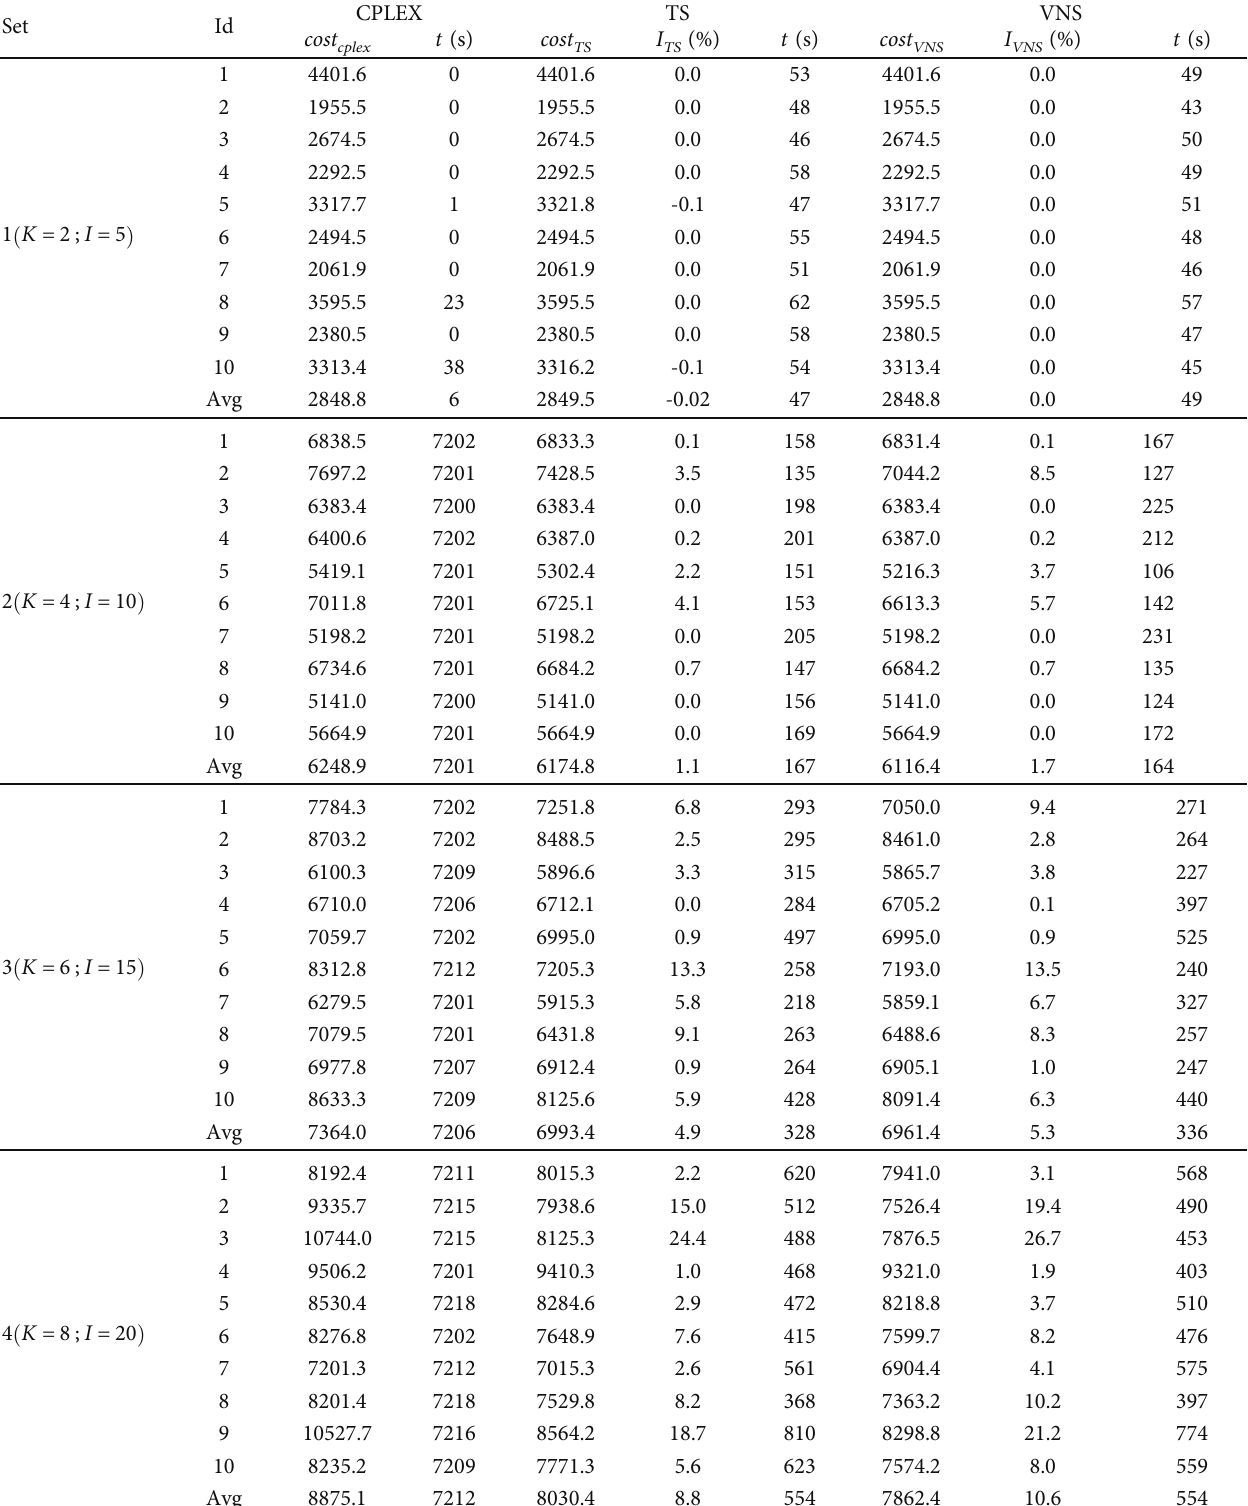
Table 1: Results on randomly generated small-sized